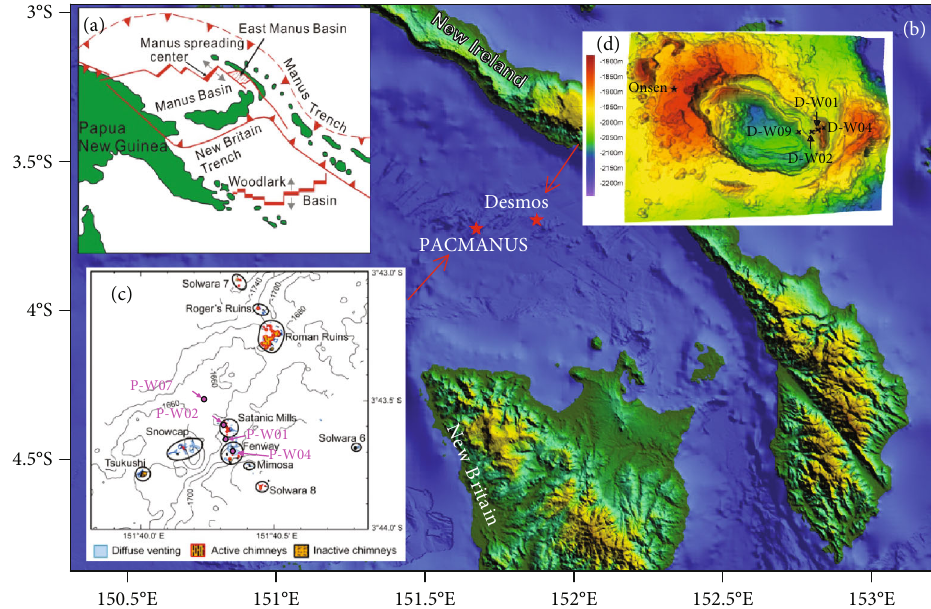
Figure 1: (a) Tectonic map of the Manus Basin (modi fi ed from Binns et al. 1995). (b) Location of hydrothermal fi elds in the eastern Manus back-arc basin (bathymetric map and data were obtained from http://www.geomapapp.org/index.htm). (c) Location of CTD stations in the Satanic Mills and Fenway vent sites in the PACMANUS hydrothermal fi eld (modi fi ed from [34]). (d) Location of CTD stations in the Desmos hydrothermal fi eld (modi fi ed from